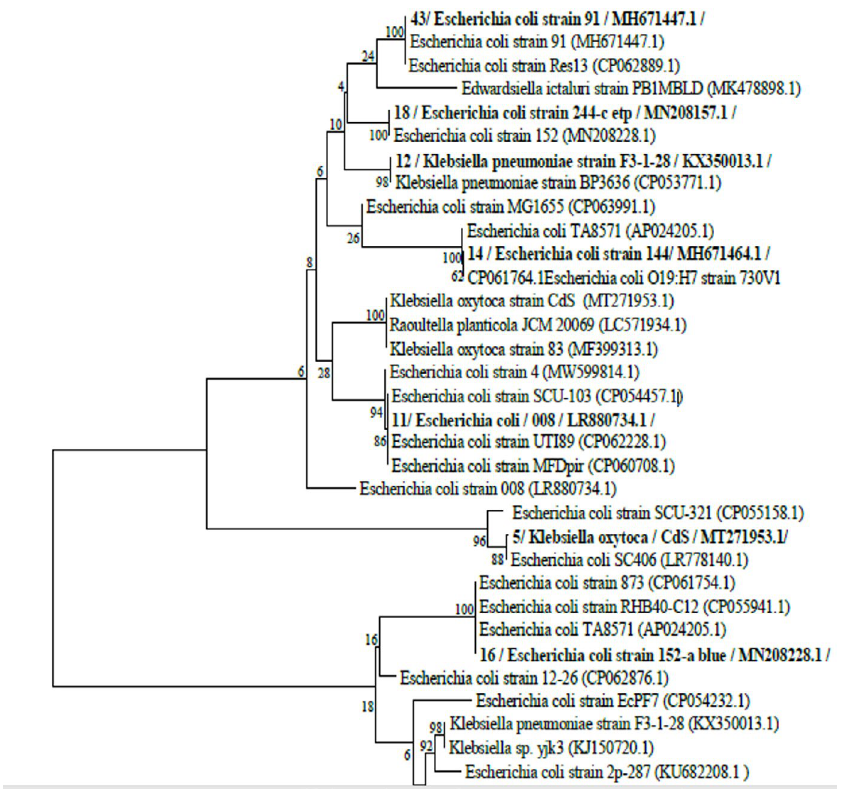
Fig. 2. The phylogenetic tree of the highest resistance rate of isolates based on 16S rRNA gene sequence analysis. Bootstrap values, shown at the nodes, were calculated from 1000 replicates. The scale bar indicates substitutions per nucleotide. The GenBank accession numbers for the 16S rRNA sequences are given in parentheses after the